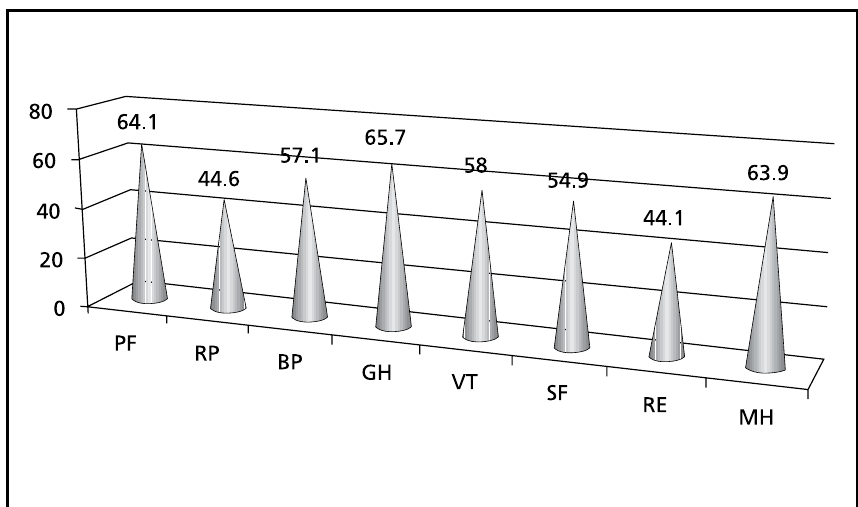
Figure i: Mean sF-36 domain scores at six months after discharge (n =